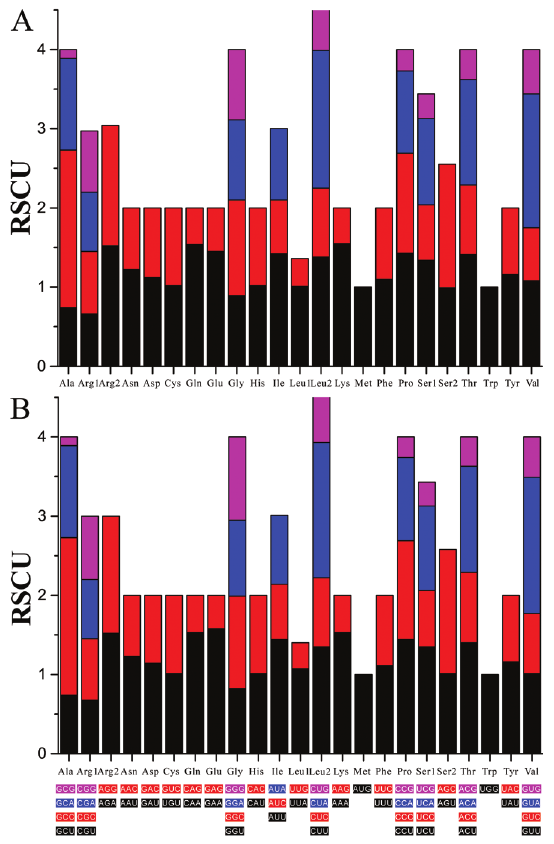
Figure 2. Relative synonymous codon usage (RSCU) in the mitogenomes of the T. brachyrhabdion A and T. gracilis B .